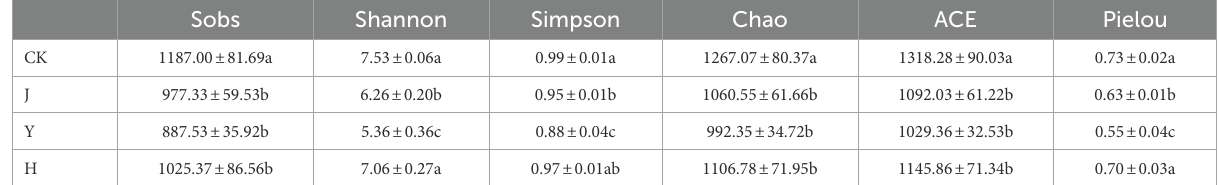
TABLE 9 Bacterial community diversity indices in soybean-potted rhizosphere. Sobs Shannon Simpson Chao ACE